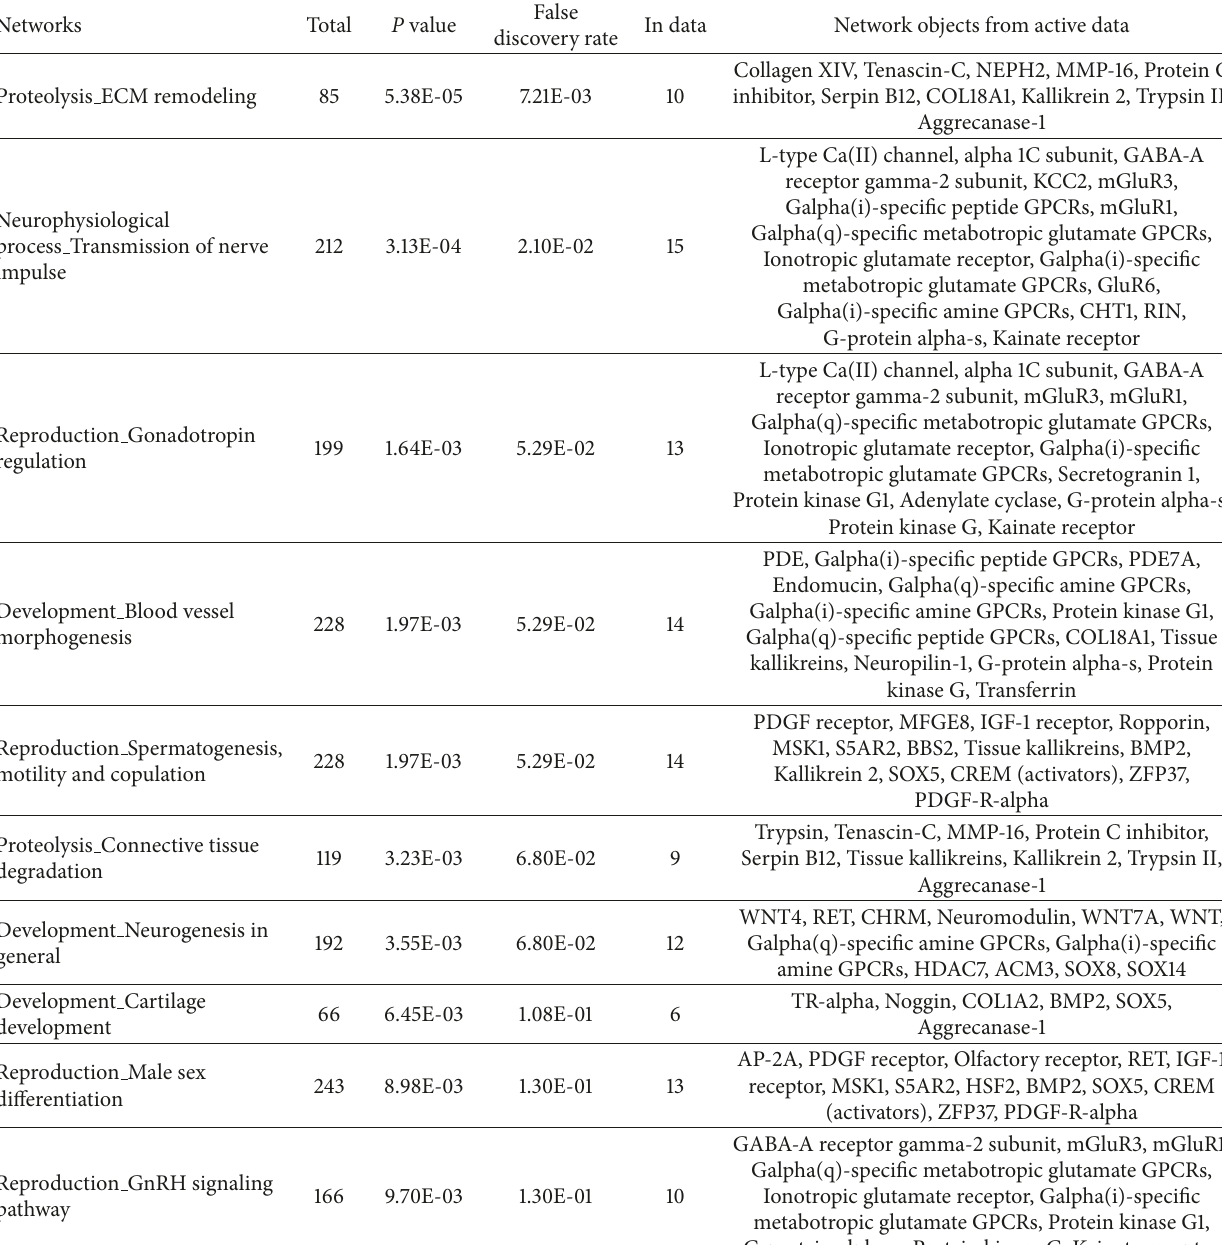
Table 2: Biological process networks for 974 genes whose expression was negatively correlated with CD4+ peripheral blood cells and